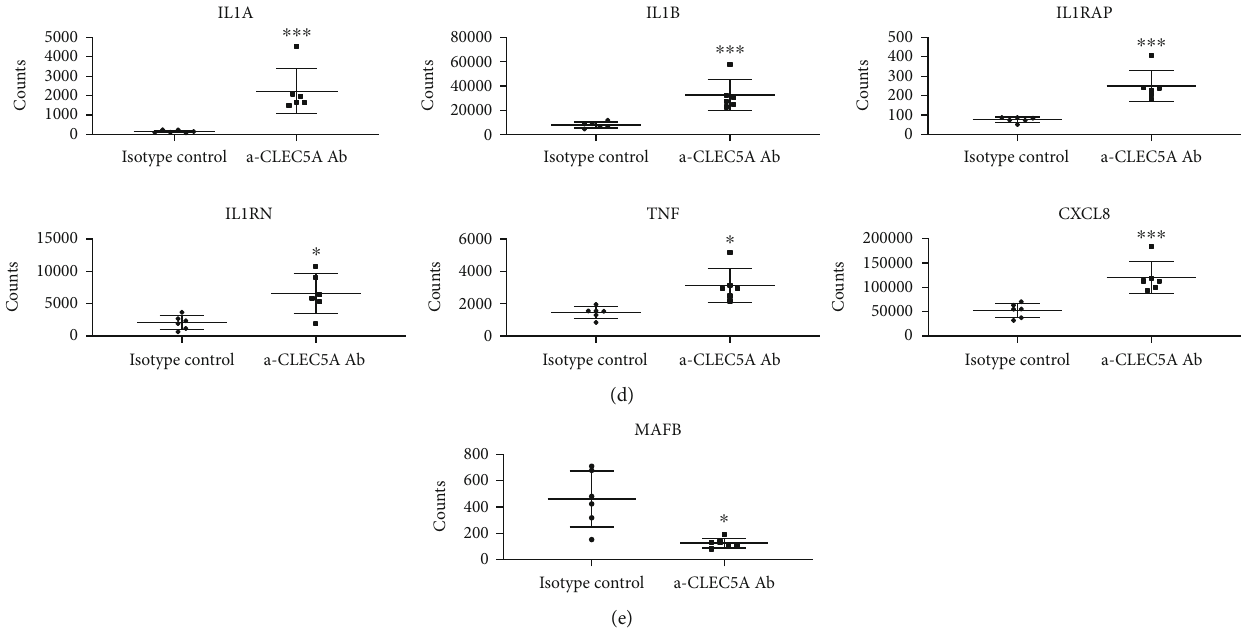
Figure 6: CLEC5A agonistic Ab induces transcriptome changes in myeloid cell-speci fi c genes. M0 MdM generated from same six donors as in Figure 5 were incubated for 6h either with the α -CLEC5A Ab or with the isotype ctrl (10 μ g/mL each) and then processed for the transcriptome analysis with NanoString nCounter. (a) Heat map of di ff erentially expressed genes (preselected according to the quality criteria as described in the Materials and Methods) in M0 MdM exposed to the α -CLEC5A Ab (upper rows; each donor represented separately) as compared to the isotype ctrl (bottom rows). (b – e) Box plots showing expression of selected genes in M0 MdM upon treatment with α -CLEC5A Ab or isotype. Depicted are representative genes encoding soluble mediators (b), myeloid cell-speci fi c surface receptors (c), selected cytokines from the IL-1 cytokine family with their functional partners (d), and a myeloid cell-speci fi c transcription factor MAFB (e). Values represent mean and SD calculated from NanoString raw counts (each dot represents one individual donor). Shown is the summary result from two independent experiments with six donors; ∗ p < 0 : 033 , ∗∗ p < 0 : 002 , and ∗∗∗ p < 0 : 001